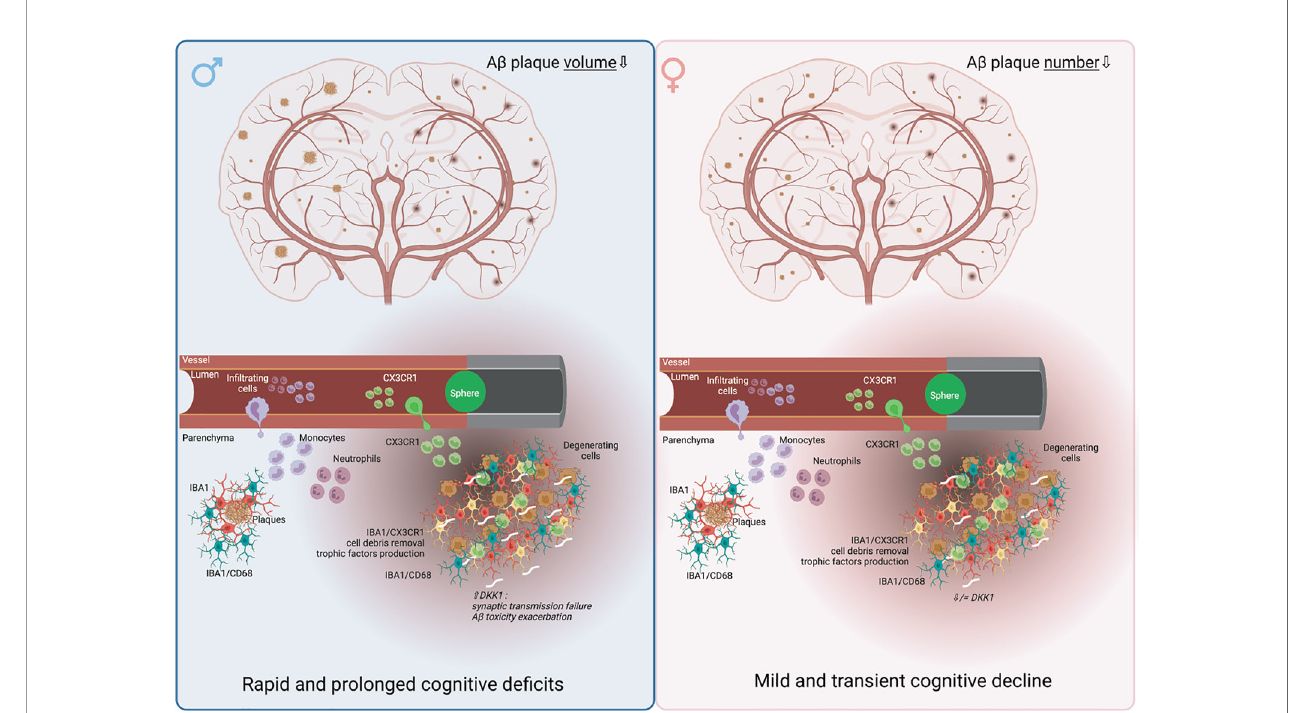
FIGURE 11 | A scheme illustrating impact of multifocal microinfarcts on AD-like pathology in mice. In male APP/PS1 mice, microinfarcts decrease the volume of A b plaques, which could be associated with the activation of microglial cells and the moderate recruitment of peripheral CX3CR1 high monocytes at the lesion site and A b plaques. However, DKK1 expression increases at the lesion sites, presumably contributing to the rapid and prolonged cognitive de fi cits. In females, microinfarcts decrease the number of A b plaques, which could be associated with the potent activation of microglia and the important recruitment of peripheral CX3CR1 high monocytes at the lesion site and A b plaques. DKK1 expression, which is repressed by estrogens, remains low at the lesion sites, presumably leading to mild and transient cognitive decline. Created with